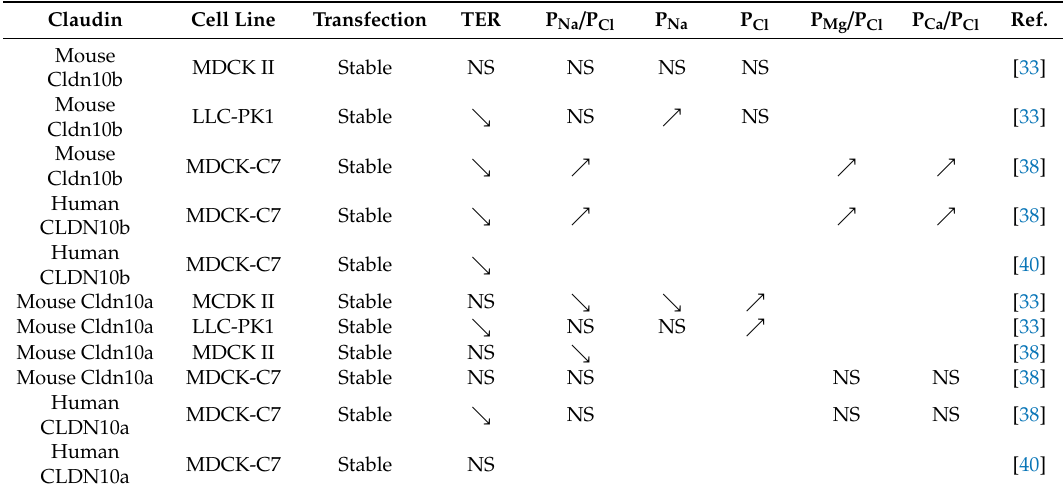
Table 3. Function of claudin 10b according to heterologous expression studies in cell